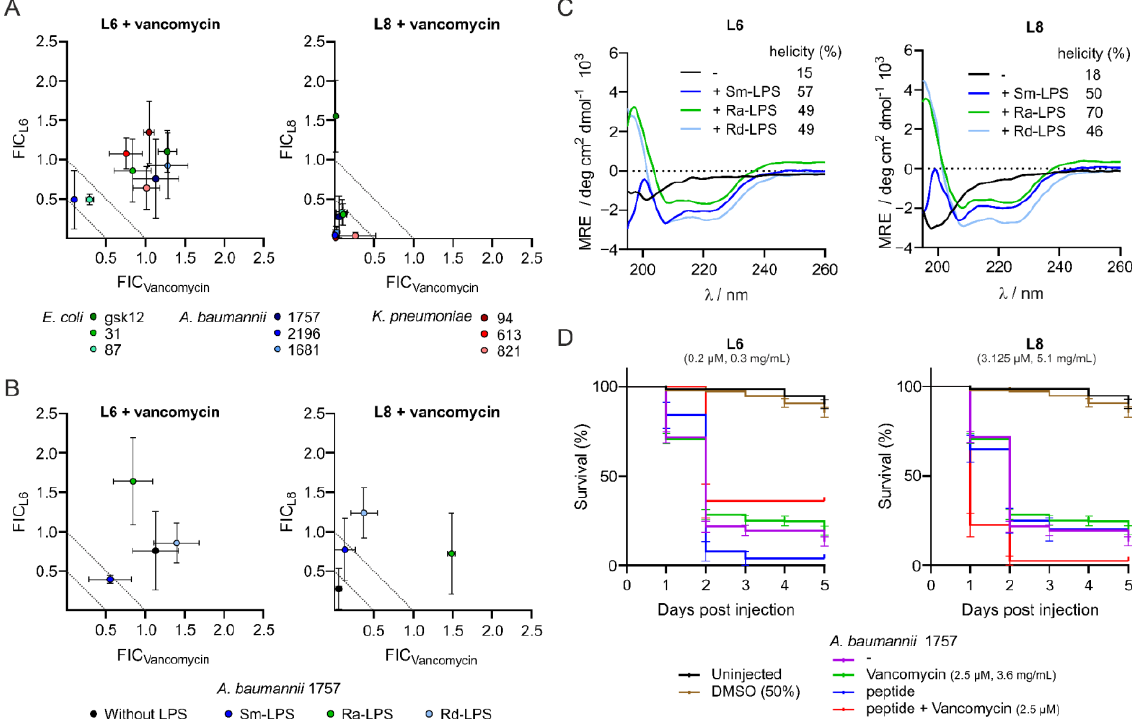
Figure 1. Peptides L6 and L8 are active in vitro against Gram-negative clinical isolates and interact with LPS but have limited activity in vivo. In vitro MIC values of peptides or vancomycin alone and MIC values of peptides combined with vancomycin or vancomycin in combination with peptides against Gram-negative bacteria were determined via checkerboard assays either in medium containing no LPS ( A ) or in medium containing smooth (Sm) LPS, rough (Ra) LPS or deep rough (Rd) LPS ( B ). The FIC values were defined as the ratio of either the MIC value of the peptide in combination with vancomycin over the MIC value of the peptide alone (FIC L6 and FIC L8 ) or the ratio of the MIC value of vancomycin combined with peptide over the MIC value of vancomycin alone (FIC Vancomycin ). The degree of α -helicity of L6 and L8 either in medium containing no LPS, Sm-LPS, Ra-LPS or Rd-LPS was determined with CD spectroscopy. Relative helicity was calculated using circular dichroism analysis using neural networks (CDNN) software ( C ). Zebrafish larvae survival rates after infection with A. baumannii 1757 and treatment with peptides, vancomycin or combinations of peptide and vancomycin via caudal vein injection ( D ). The data are presented as mean ± standard deviation from three independent experiments.